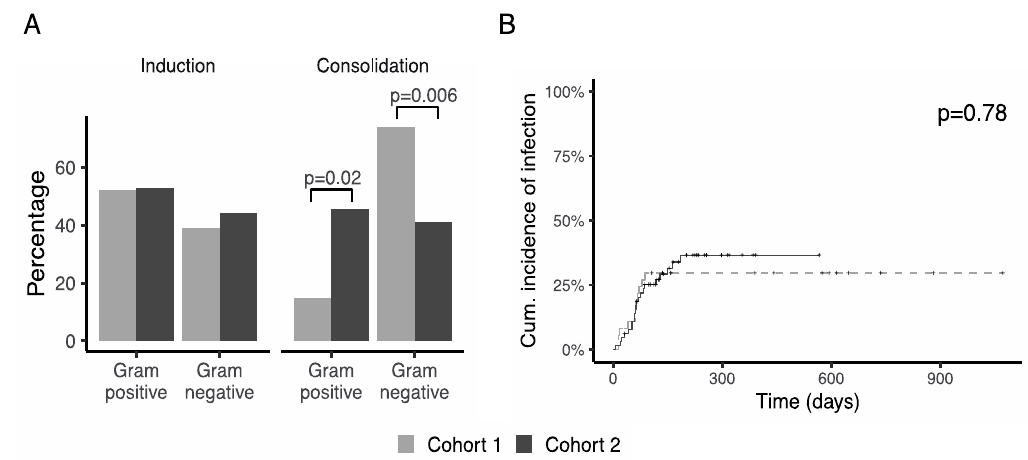
Figure 2. Incidence of infection. ( A ) Distribution of Gram-positive and Gram-negative infections during induction and consolidation cycles in both cohorts. A significant reduction in Gram-negative bacterial infections during consolidation cycles was observed in cohort 2. ( B ) Cumulative incidence of infection by multi-resistant Gram-negative bacteria, accounting for the competing risk of death. Table 4. Univariate comparisons of multi-resistant Gram negative bacteria incidence between cohorts, together with bacterial susceptibility pattern. Percentage is referred to bacteria of the same species recovered from cultures during the period. MR-GNB: multi-resistant Gram negative bacteria. ESBL: Extended Spectrum β -Lactamase producing. CPN: carbapenemase-producing. ESBL-CPN: Extended Spectrum β -Lactamase and carbapenemase-producing. XDR: Extremely Drug Resistant. MR-GNB and Resistance Pattern N / Total